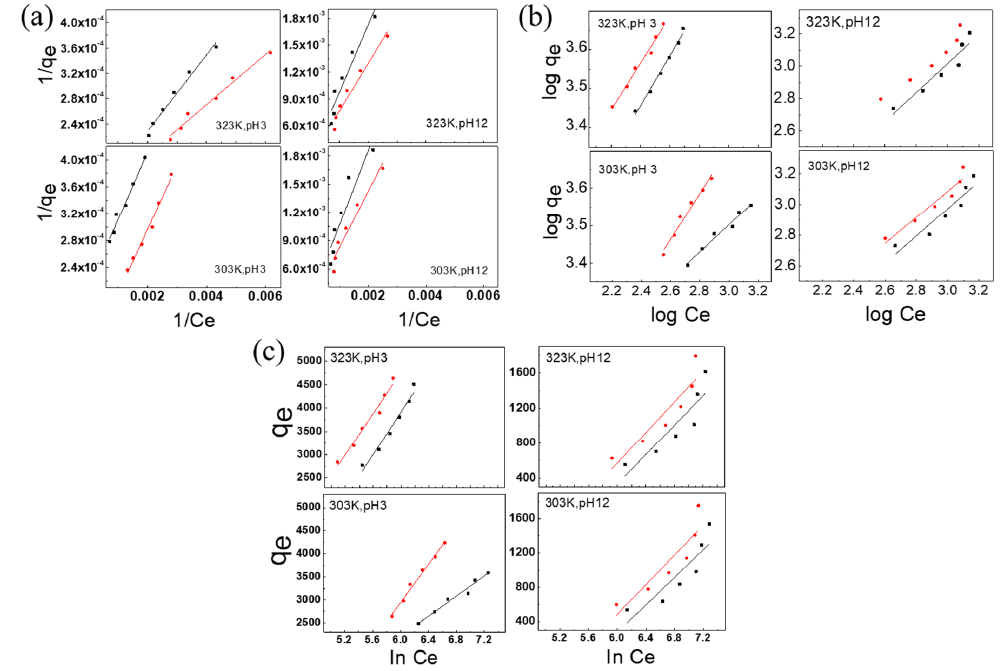
Figure 6. Isothermal adsorption models for the two adsorbent materials ( ■ CS, ● CSGO) at different temperatures (303 and 323 K): ( a ) Langmuir isotherm; ( b ) Freundlich isotherm; ( c ) Temkin isotherm. Table 1. Isotherm models and corresponding parameters for the adsorption of RB221 by di ff erent adsorbent materials at di ff erent